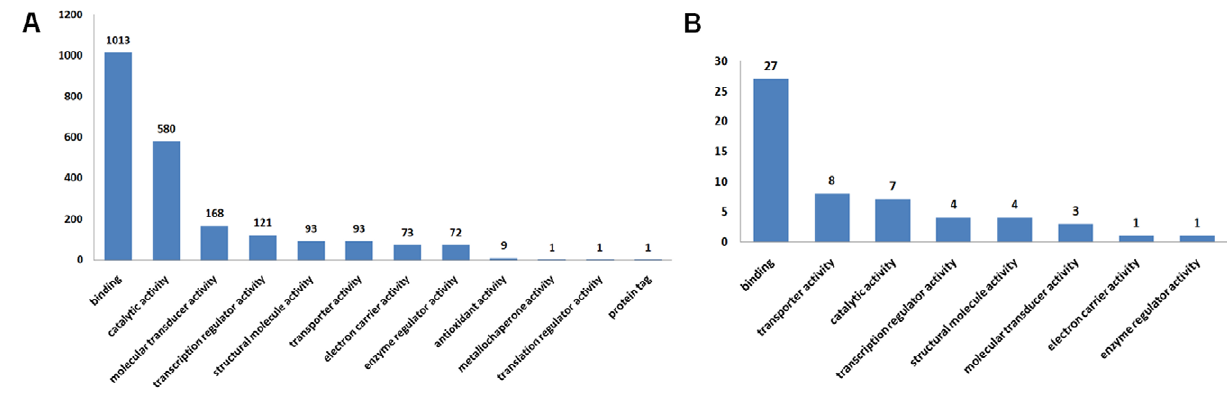
Figure 5. Functional Gene Ontology (GO) annotations of primary proteins. (A) GO molecular functions of the 1,432 primary proteins involved in the 551,994 interaction pairs that were tested for collisions. (B) GO molecular functions of the 37 primary proteins involved in the 4,874 interaction pairs with structural collisions.